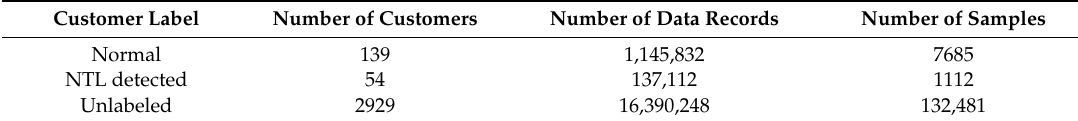
Table 2. Description of data